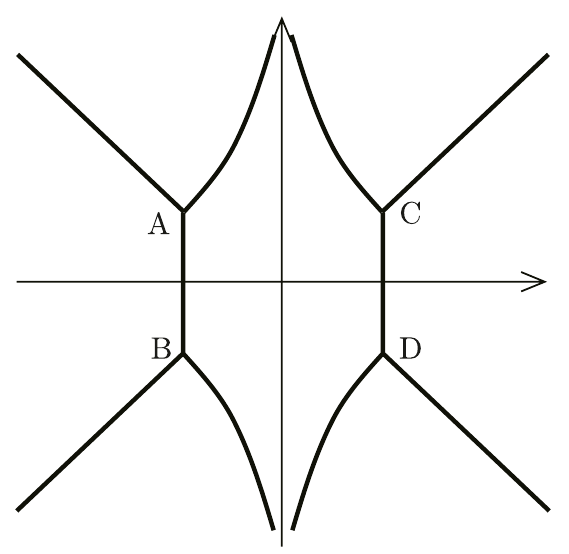
Figure 7 . The Stokes lines for the inverted quartic potential with E > 0